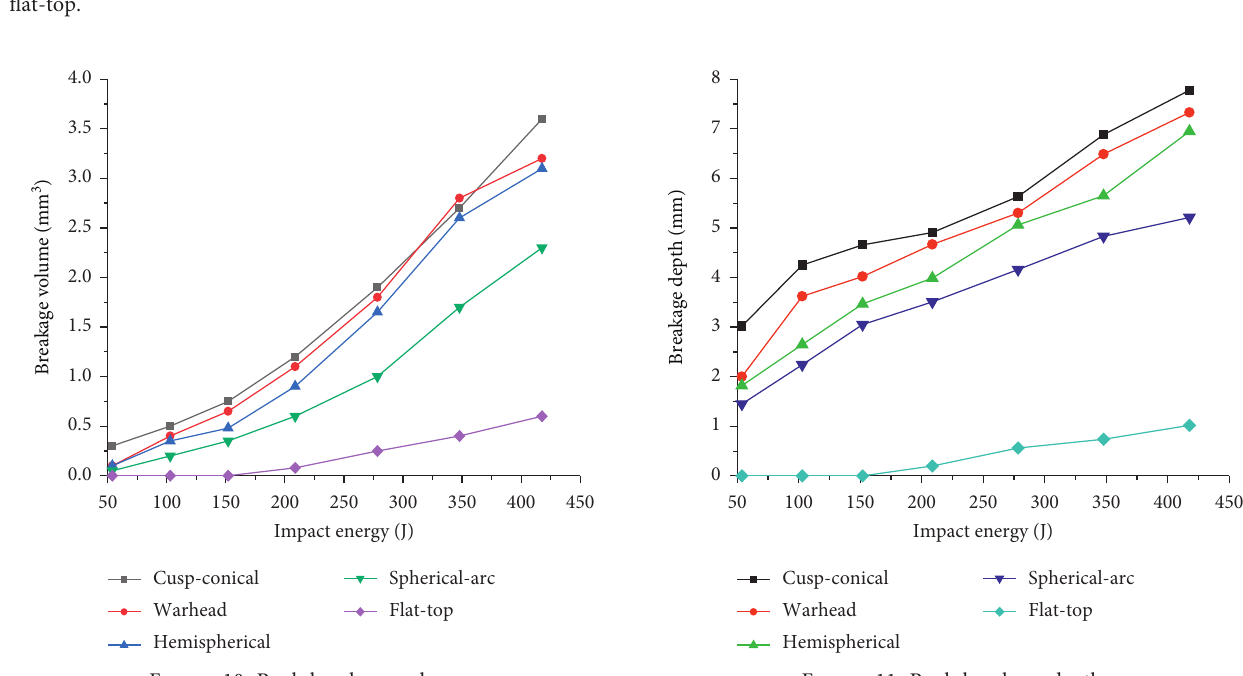
Figure 9: Rock breakage extent under different indenter shapes: (a) cusp-conical, (b) warhead, (c) hemispherical, (d) spherical-arc, and (e) flat-top.